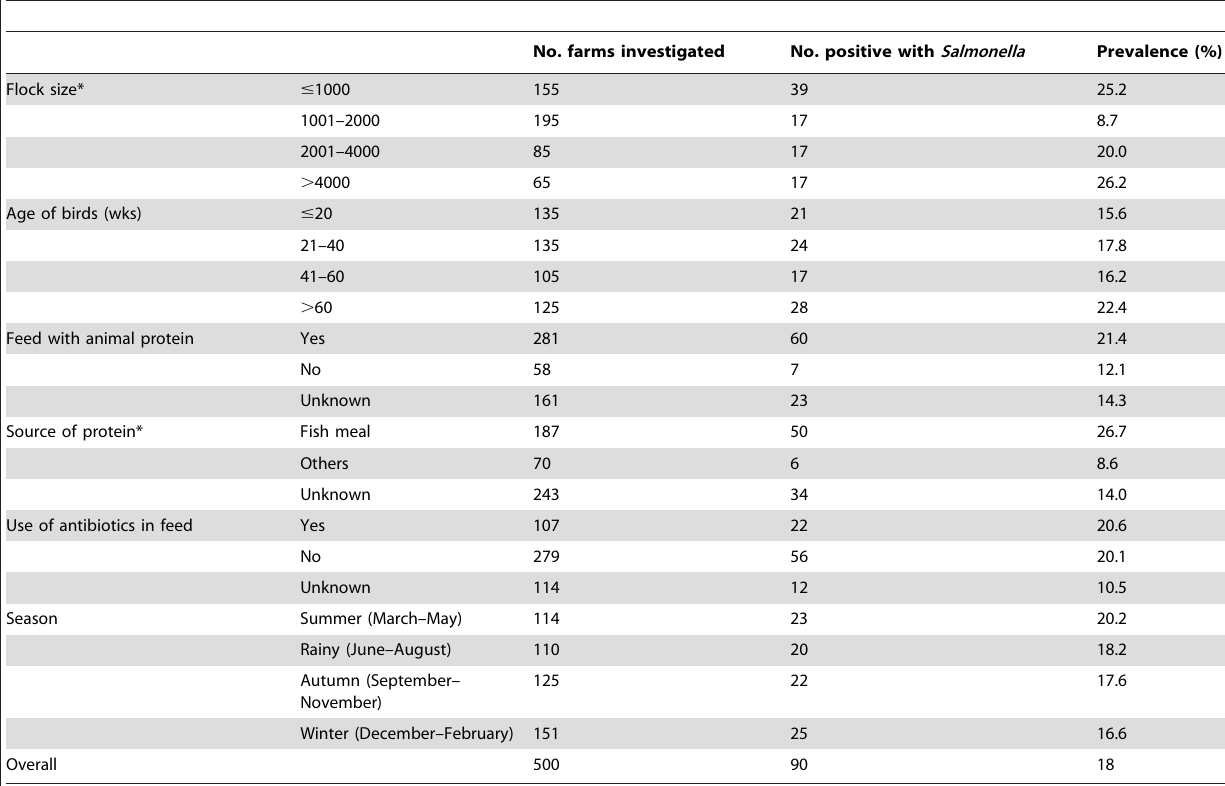
Table 1. Prevalence of motile Salmonella in commercial layer poultry farms in Bangladesh, 2009–2010 (n= 500).